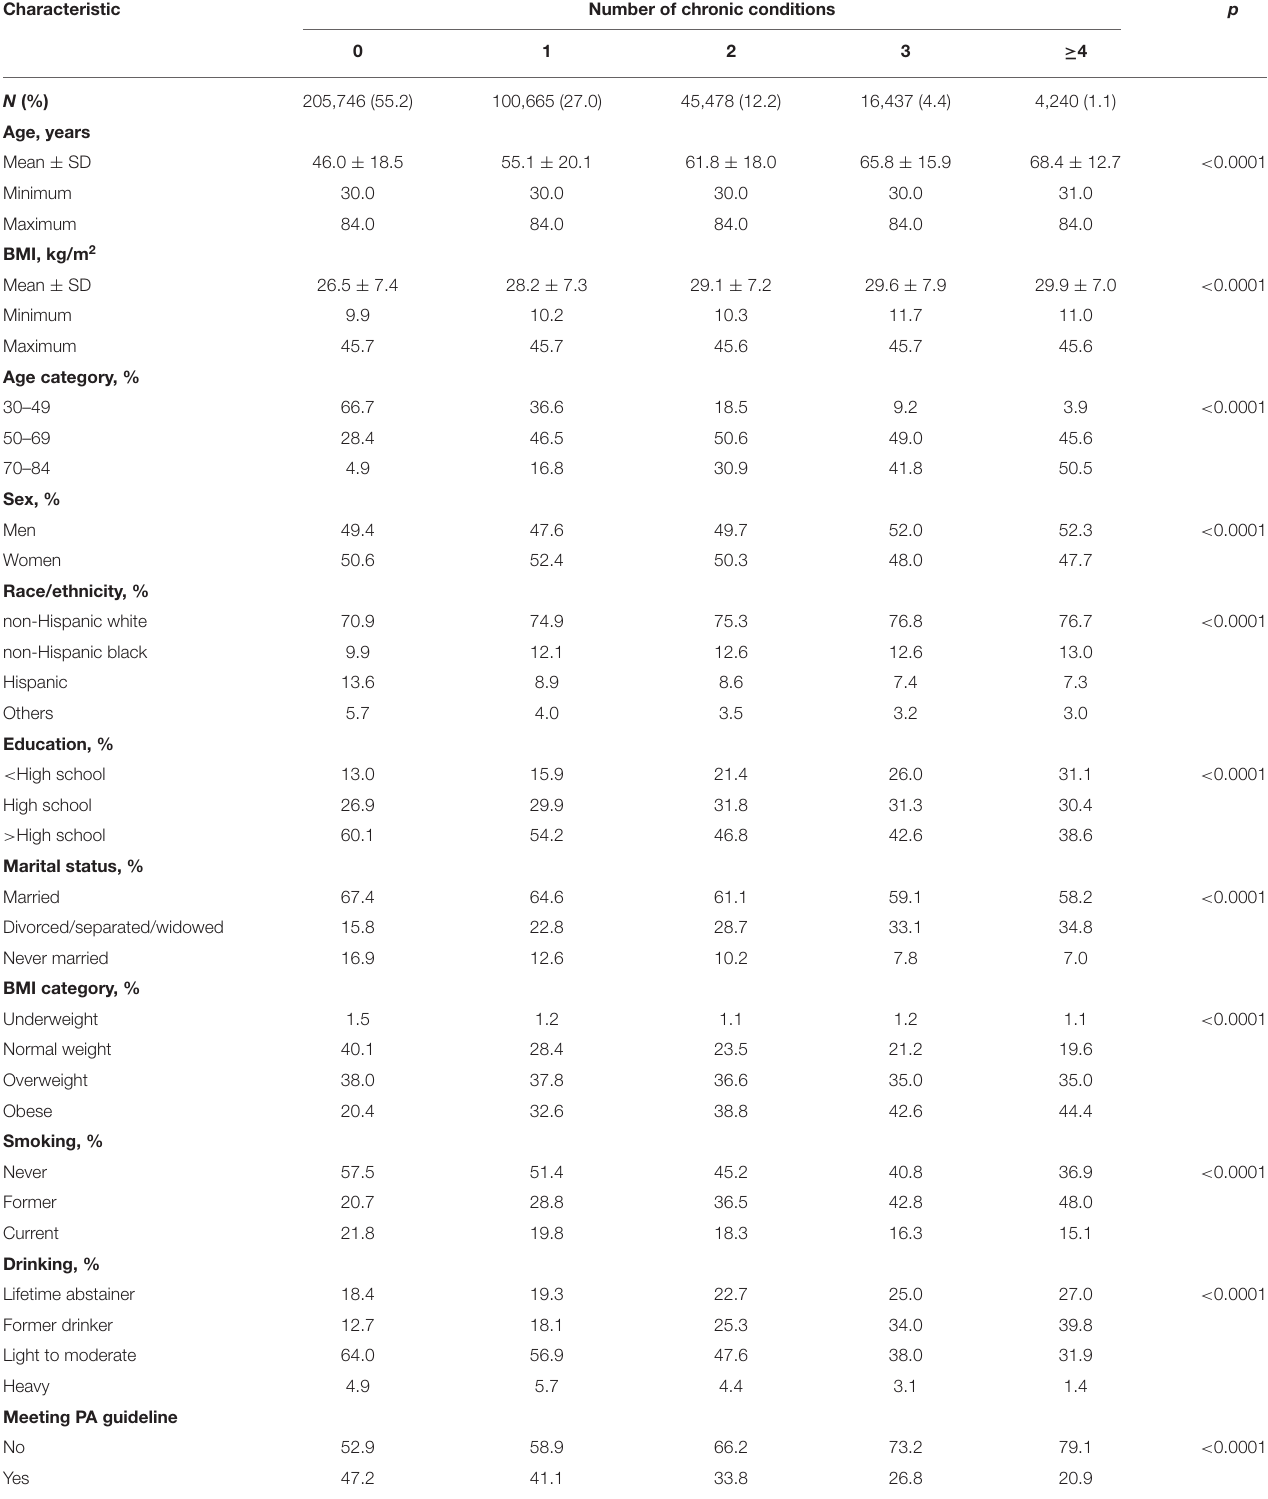
TABLE 1 | Baseline characteristics according to the number of chronic conditions, NHIS, 1997–2014. Characteristic Number of chronic